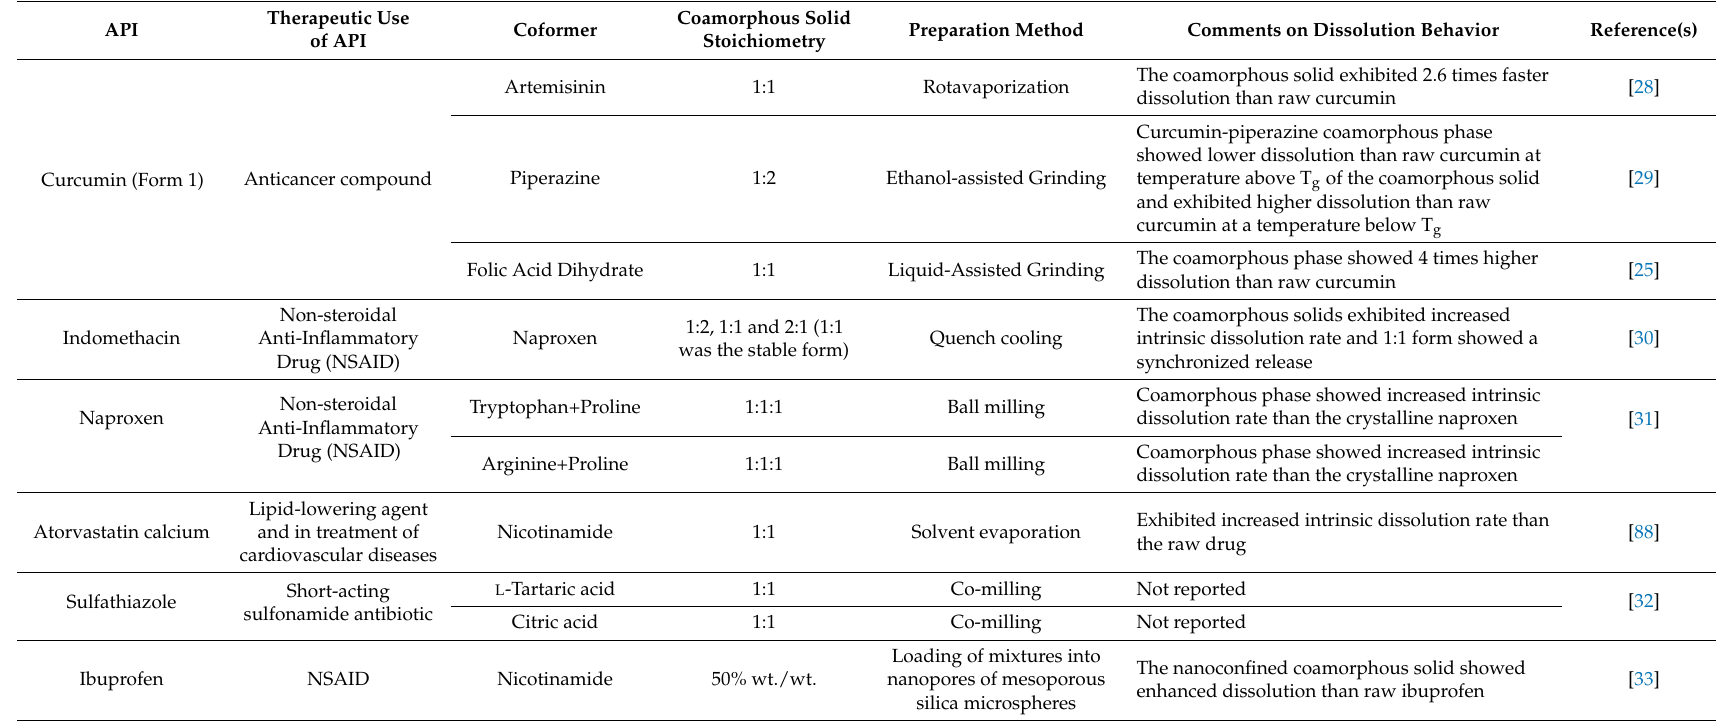
Table 5. Summary of a few reports on drug coamorphous solids available in the